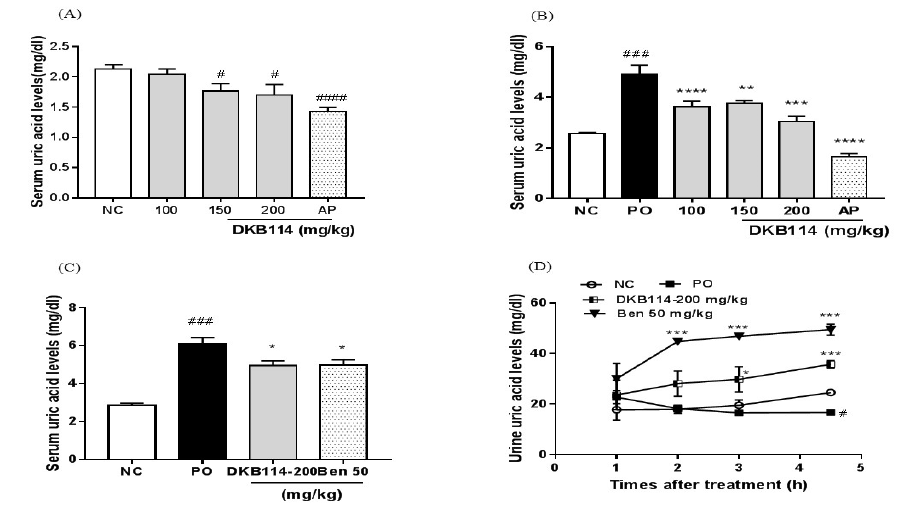
Figure 1. Effects of DKB114 on serum and urinary uric acid levels in normal rats and rats with PO-induced hyperuricemia. ( A ) Serum uric acid levels in normal rats. ( B ) and ( C ) Serum uric acid levels in rats with PO-induced hyperuricemia (Exp1 and 2), and ( D ) urinary uric acid levels in rats with PO-induced hyperuricemia (Exp2). Blood samples were collected 2h after PO injection and DKB114 treatment. Urine samples were collected using metabolic cages at indicated times after PO injection and DKB114 treatment. NC, normal control group; PO, potassium oxonate-induced hyperuricemia group; DKB114, a mixture of ethanol extracts of Chrysanthemum indicum Linne flower (CF) and Cinnamomum cassia (L.) J. Presl bark (CB) in a 1:2 ratio; AP 10, 10 mg/kg allopurinol; Ben 50: 50 mg/kg benzbromarone. Data are expressed as the mean ± SEM ( n = 6–10). # p < 0.05, ### p < 0.005, and #### p < 0.001 vs. the NC group; * p < 0.05, ** p < 0.01, *** p < 0.005, and **** p < 0.001 vs. the PO group.